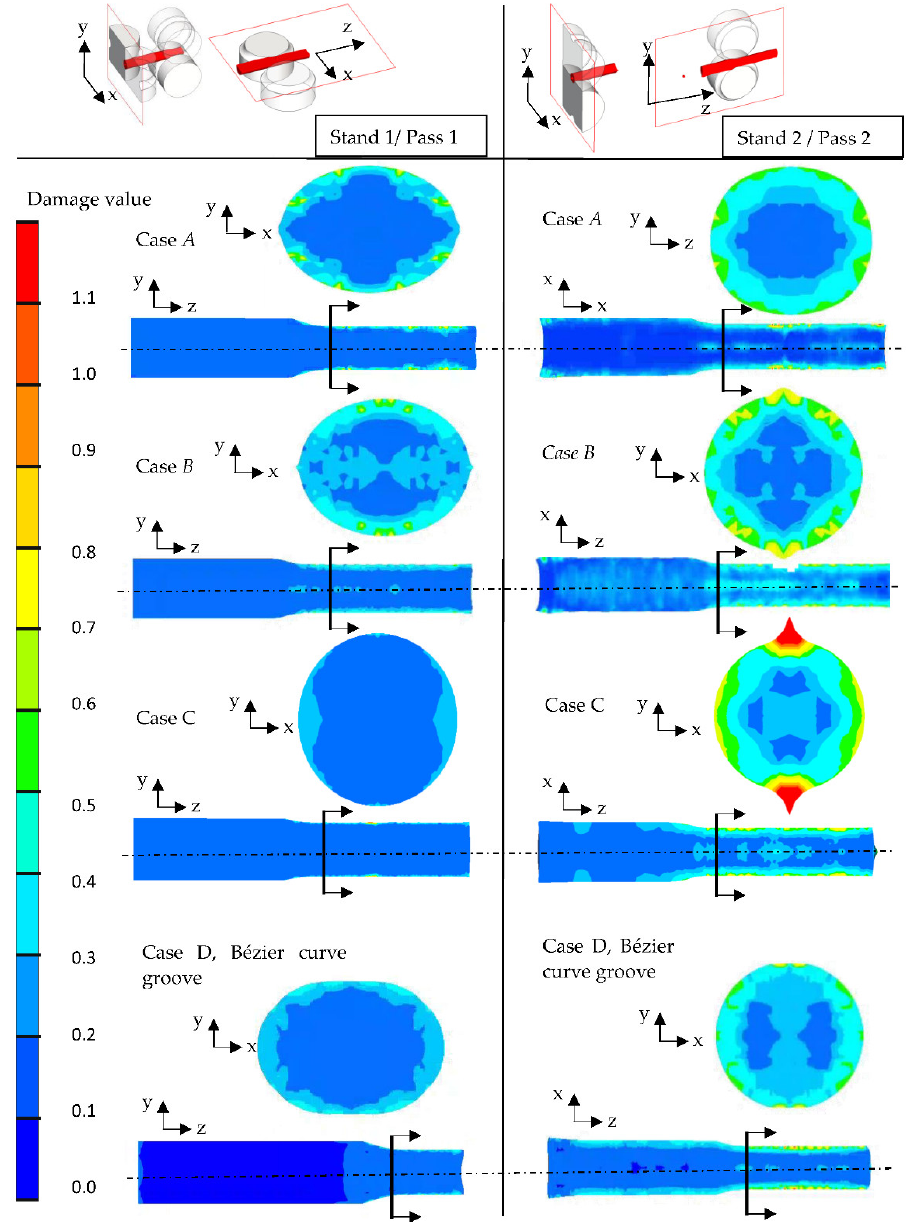
Figure 8. The damage value distributions at the cross sections along the vertical direction and the rolling direction.